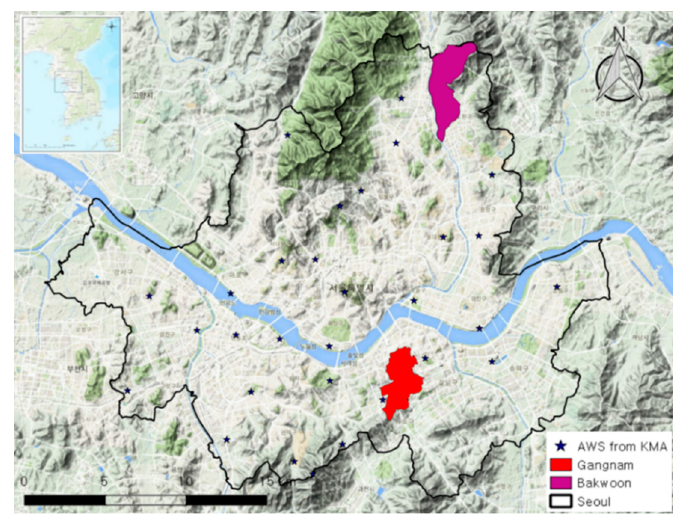
Figure 2 . Boundary of the Seoul metropolitan area for which quantitative precipitation forecasts (QPFs) were obtained, locations of Korea Meteorological Administration’ (KMA’s) automatic weather stations (AWS), and boundaries of the Gangnam and Bakwoon basins studied in detail.